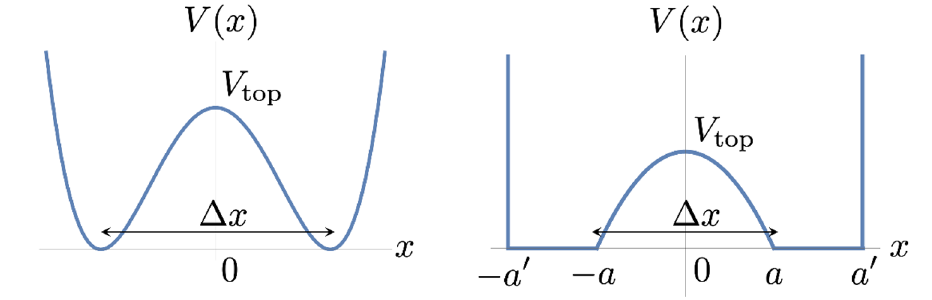
Figure 10 . A schematic picture of the potentials we use for evaluating the bound for the Lyapunov coefficient. Left: the potential (4.5). Right: the potential